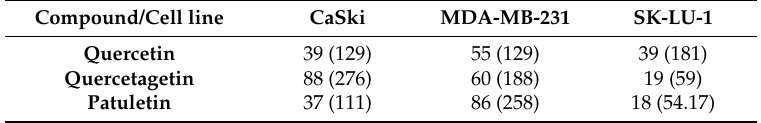
Figure 4. Dose-response curves of the antiproliferative effect of quercetin, quercetagetin and patuletin. Table 2. Antiproliferative activity of the quercetin, quercetagetin and patuletin compounds in tumor cell lines 1 .